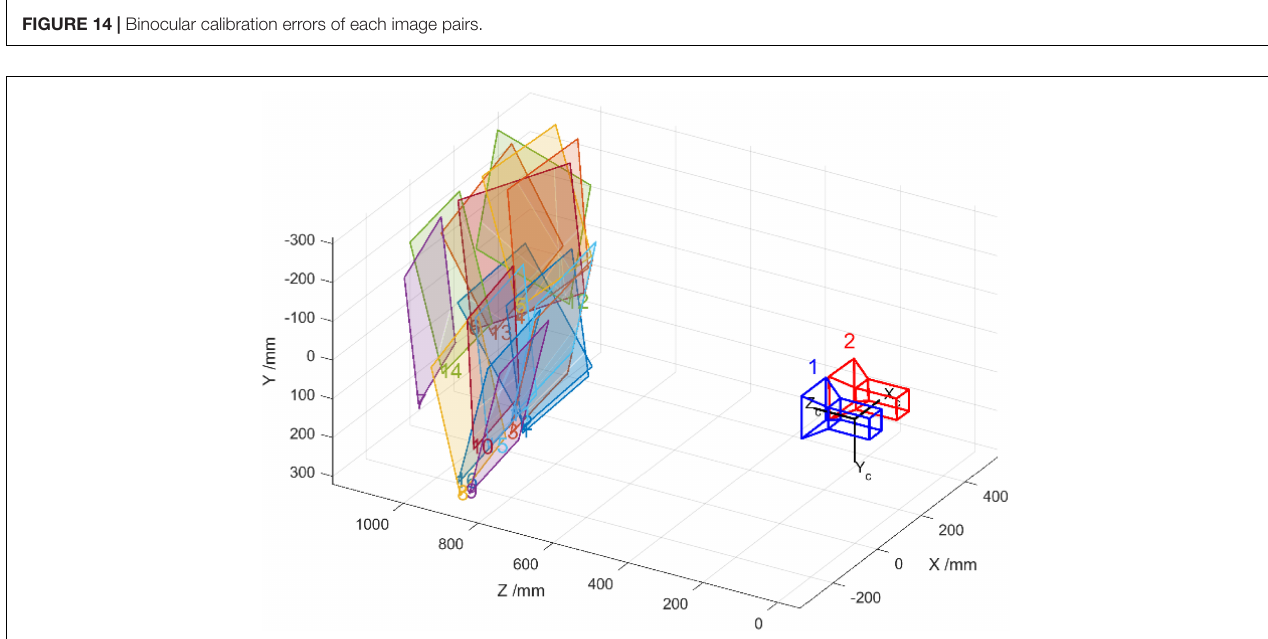
matching point pixel of point P in r direction,